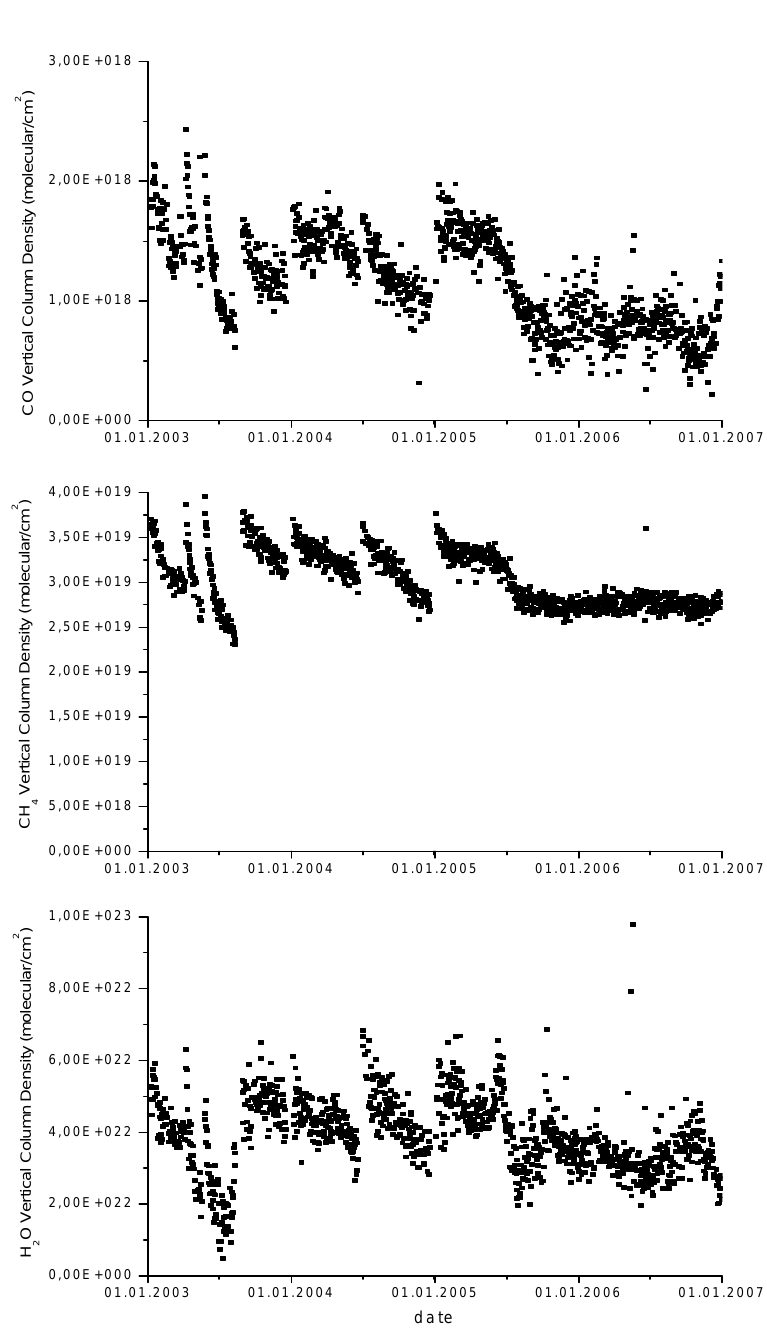
Fig. A1 Time series of the VCDs of CO (top), CH Fig. A1. Time series of the VCDs of CO (top), CH 4 (middle) and H 2 O (bottom) averaged over Sahara (20 ◦ N to 28 ◦ N; 8 ◦ W to 28 ◦ E) for each day in the period 2003 to Sahara (20°N to 28°N; 8°W to 28°E) for each day in the period 2003 to 2006.